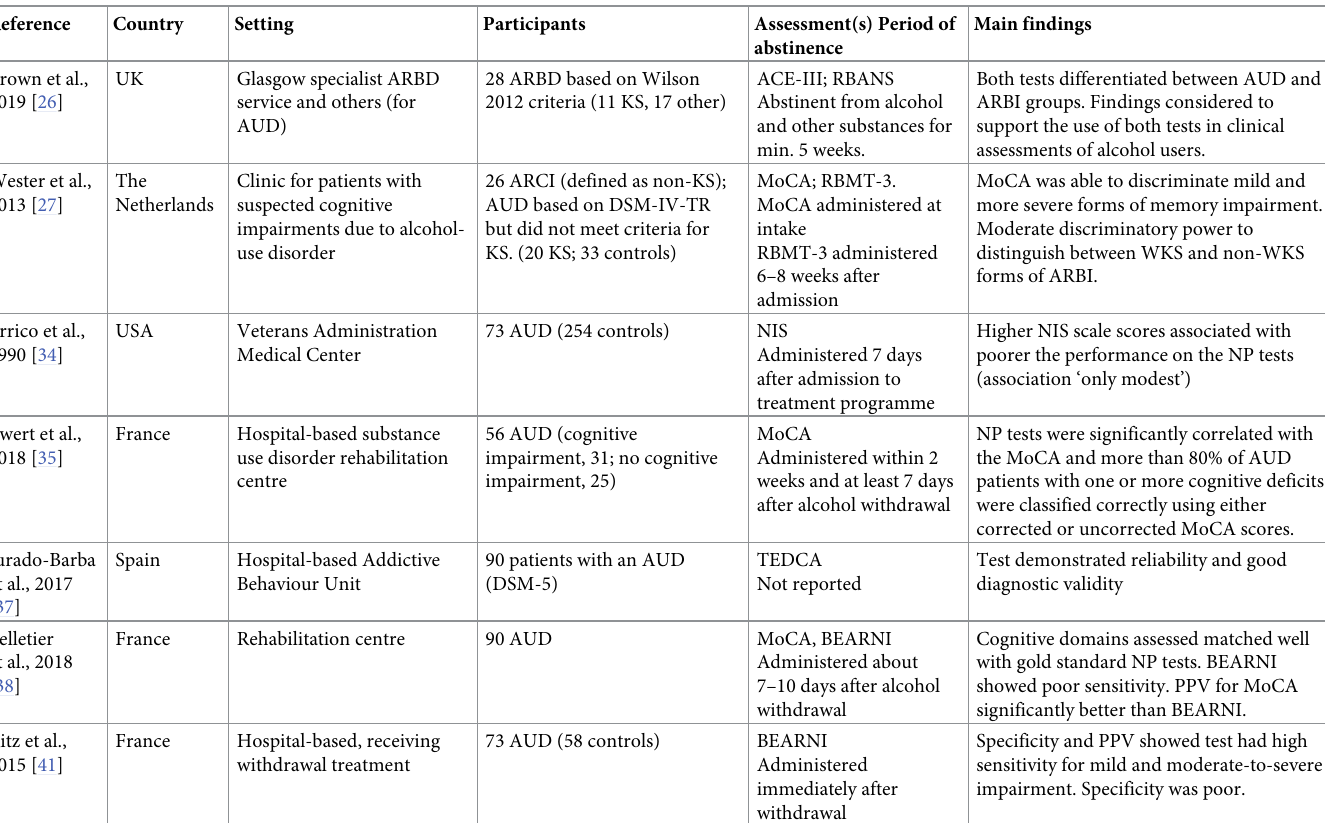
Table 4. Summary of studies: Accuracy, validity and/or reliability of a cognitive assessment